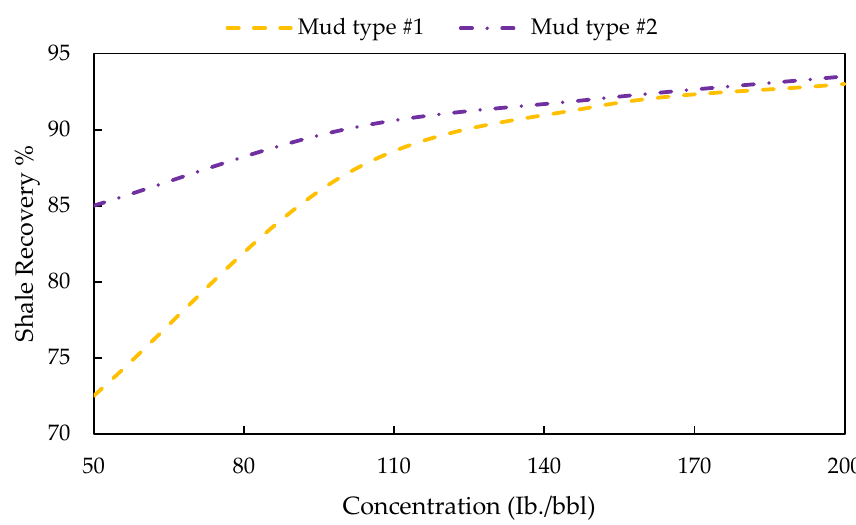
Fig. 3 Shale recovery test for two formate